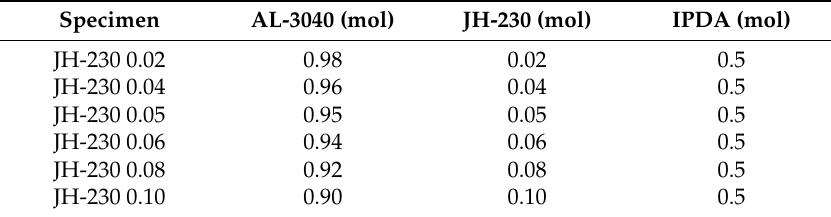
Table 1. Specimens and their specifications.